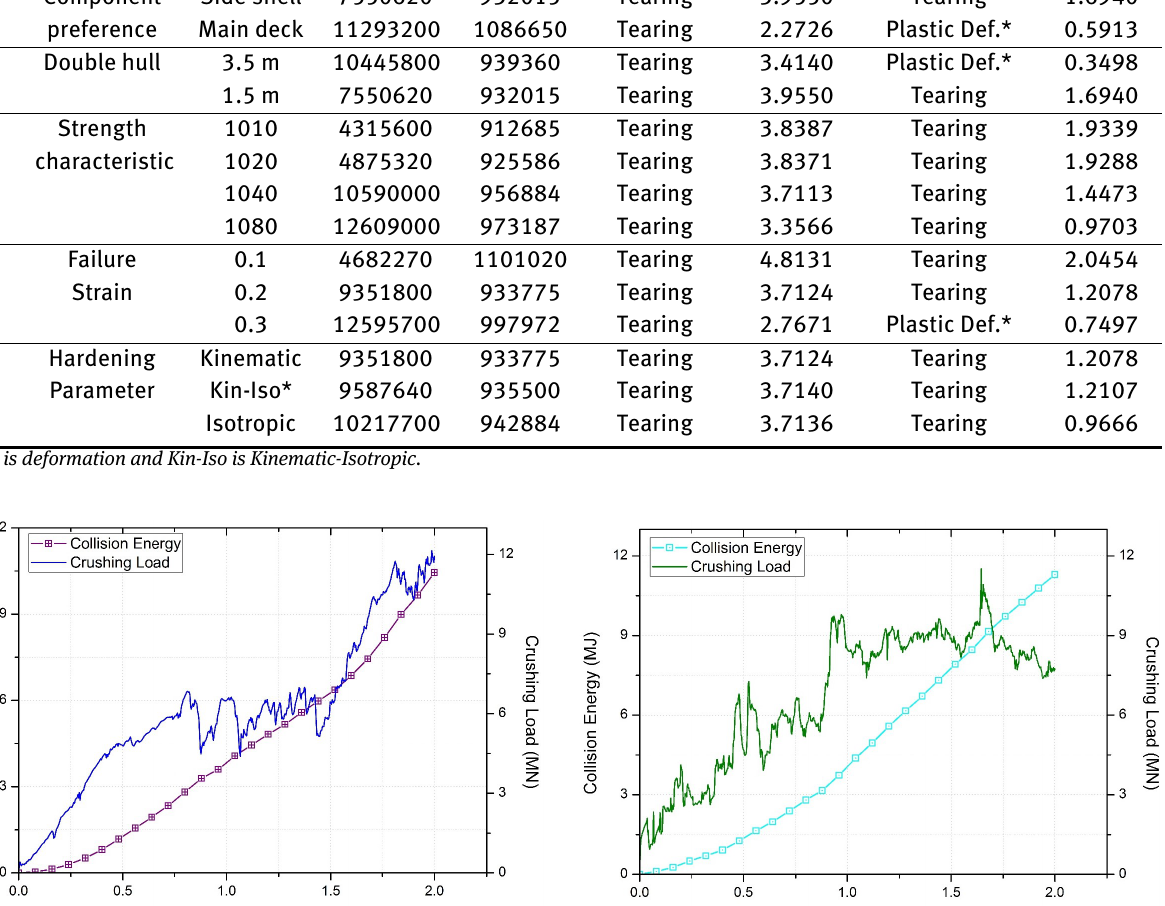
Figure 5: Energy and load characteristic of collision on main